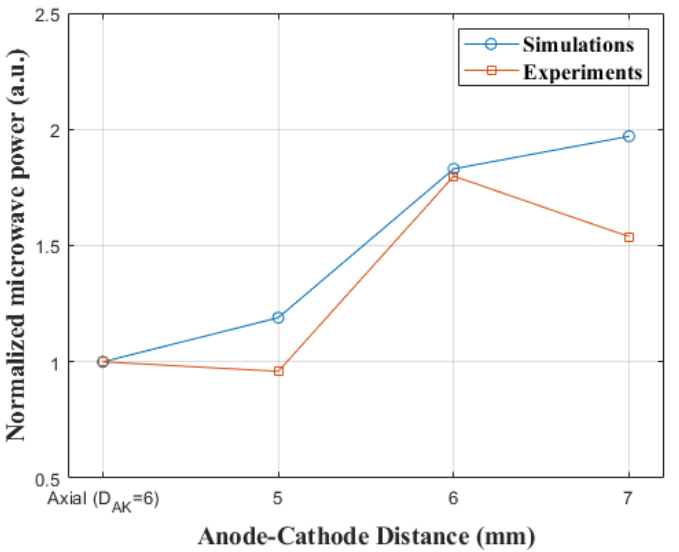
Figure 11. Normalized microwave power of the simulations and experiments as a function of the anode to cathode distance.